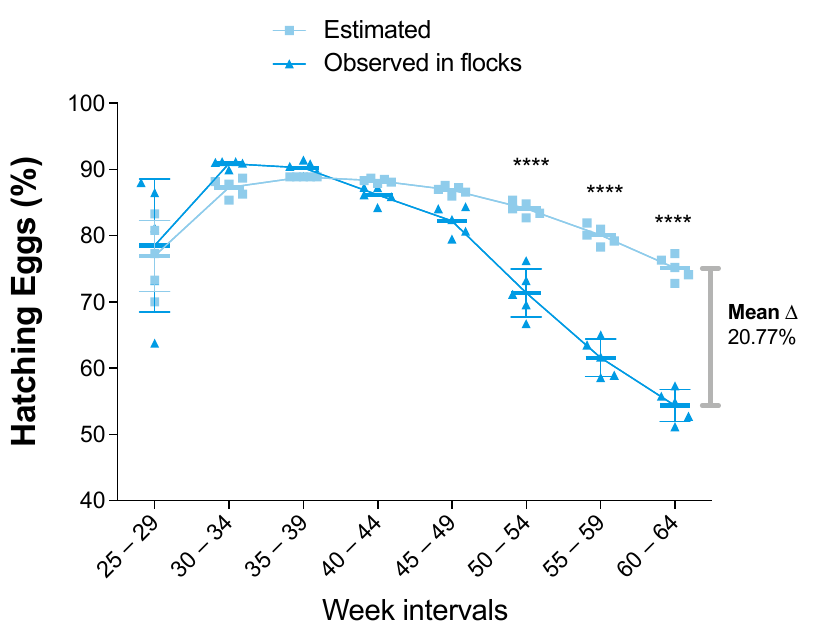
Figure 4. Percentages of Hatching Eggs (HE) for estimated and observed flocks. Results are pre- sented as mean and standard deviation, and mean differences (shown as delta “ ∆ ” mean) were calculated subtracting observed from estimated values. Comparisons were performed using the two-way ANOVA test followed by the Bonferroni correction post-hoc test. * p < 0.05; ** p < 0.005; *** p < 0.0005; **** p < 0.0001.